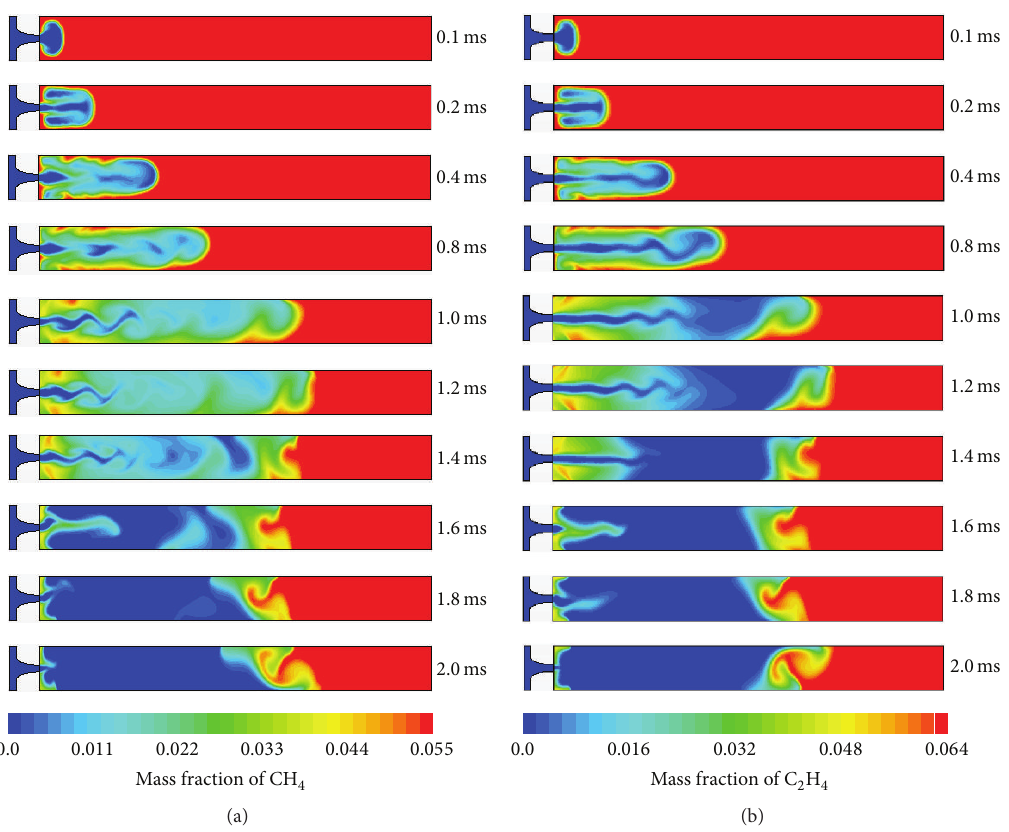
Figure 8: Fuel mass fraction: (a) methane-air combustion predicted using DRM19 (21 species) reaction mechanism; (b) ethylene-air combustion predicted using detailed reaction mechanism (32